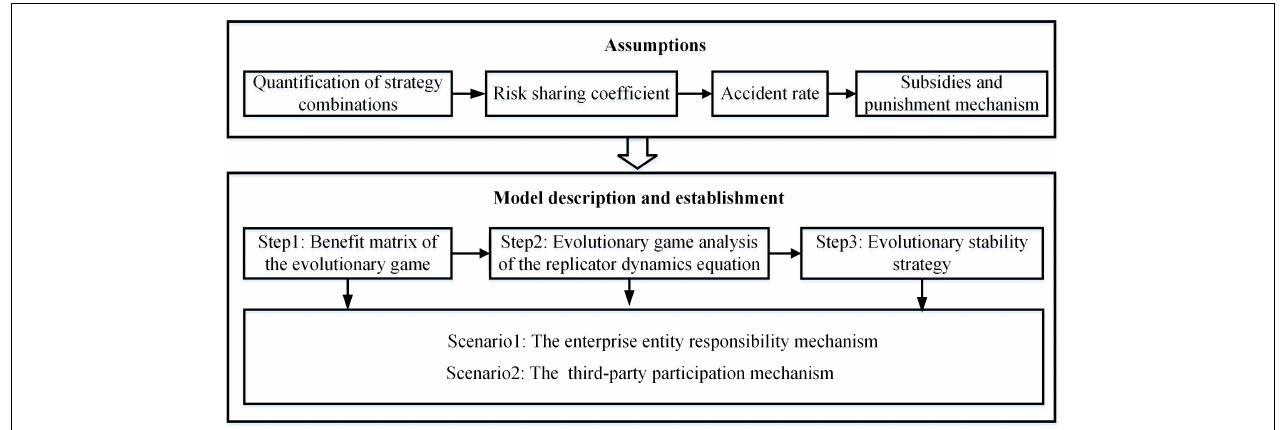
FIGURE 1 | The game analysis process of construction safety